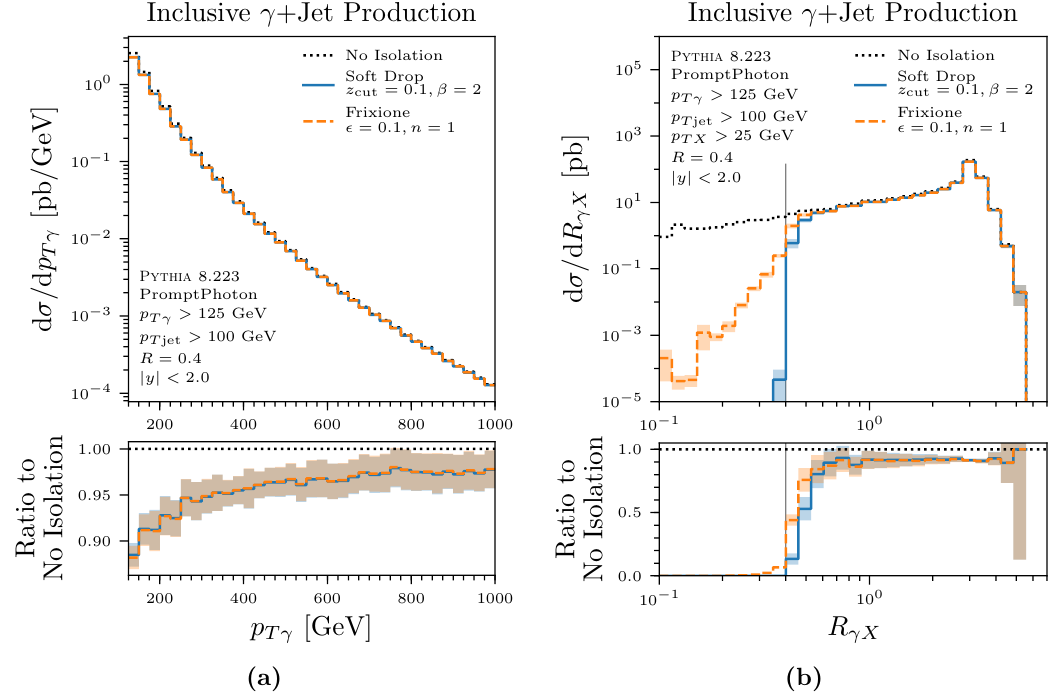
Figure 3. Inclusive (cid:13) +jet production cross sections from the Pythia PromptPhoton process, comparing the spectrum of soft drop isolation, Frixione isolation, and the hardest photon without isolation. (a) Photon transverse momentum p T(cid:13) . (b) Angle R (cid:13)X between the photon and the nearest object with p TX > 25 GeV. In both (cid:12)gures, the bottom panels show the ratios to the non-isolated case, and the shading indicates statistical uncertainties. Although the p T(cid:13) spectra are nearly identical, there are signi(cid:12)cant di(cid:11)erences in the R (cid:13)X spectra due to soft drop isolation’s democratic